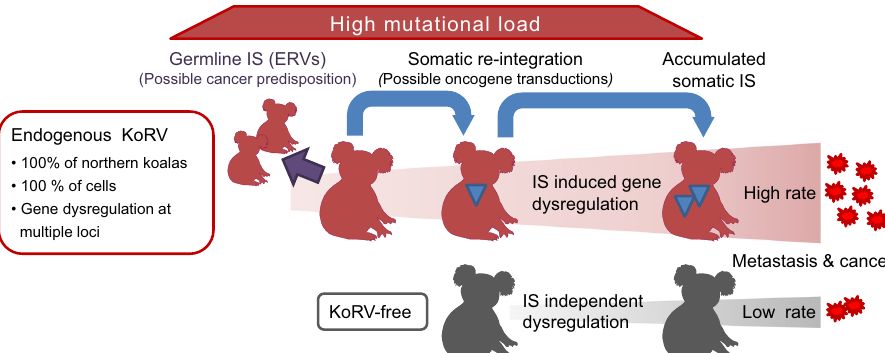
Fig. 5 Overview of KoRV transformation processes in koalas. All northern koalas carry endogenous KoRVs (red koala images) which are subject to Mendelian inheritance (purple arrow). Having multiple potentially active ERVs in every cell, with reintegration (blue arrows) leading to additional IS in somatic cells (blue triangles), would confer a tremendous mutational load on the population. Both inherited and new somatic IS can potentially dysregulate oncogenes, leading to an increased risk of transformation, with additional new integrations occurring in the transformed population of cells promoting cancer and metastasis. The potential for KoRV to transduce oncogenes also increases cancer risk. Koalas without endogenous KoRV (grey koala images) will only develop cancers (at a much lower rate) through